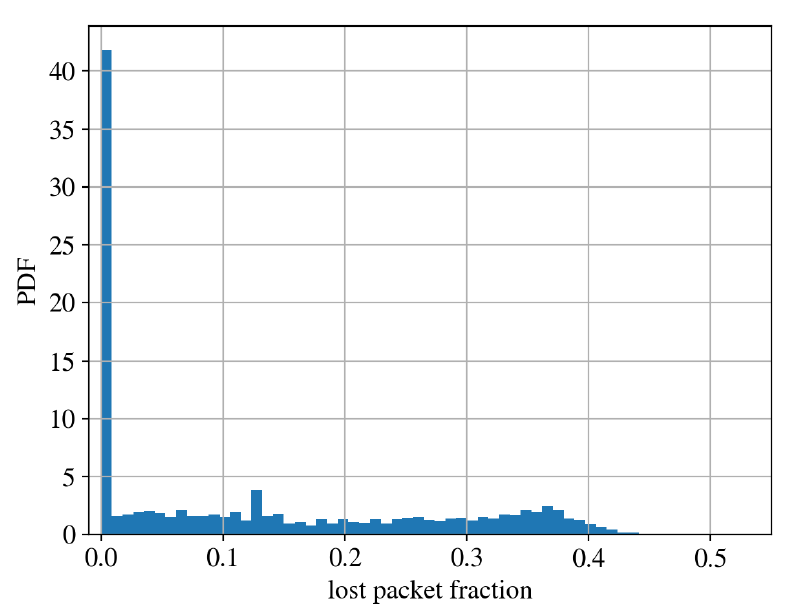
Figure 9. PDF distribution of lost packets. To compute it, we isolated the packets of each device in the network. Then, we computed the ratio of lost packets for each device. The PDF in figure is the distribution of those ratios.